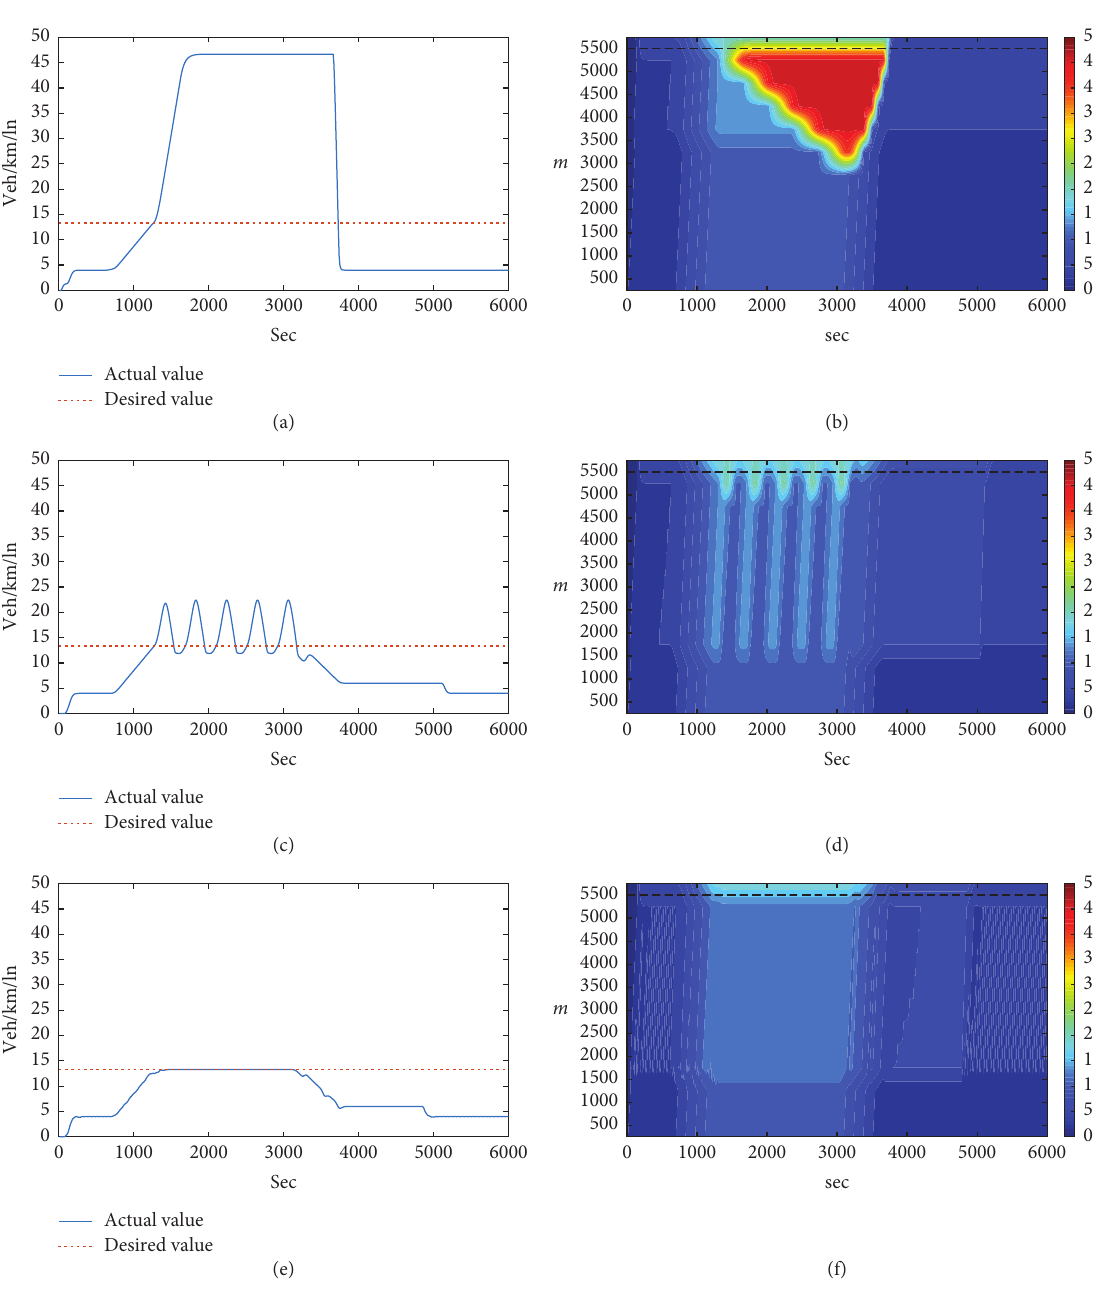
Figure 5: Comparison of traffic density time series of the control target cell (left column) and traffic density contours (right column), respectively, among the no control case (top row), the PI controller case (middle row), and the case of the proposed approach (bottom